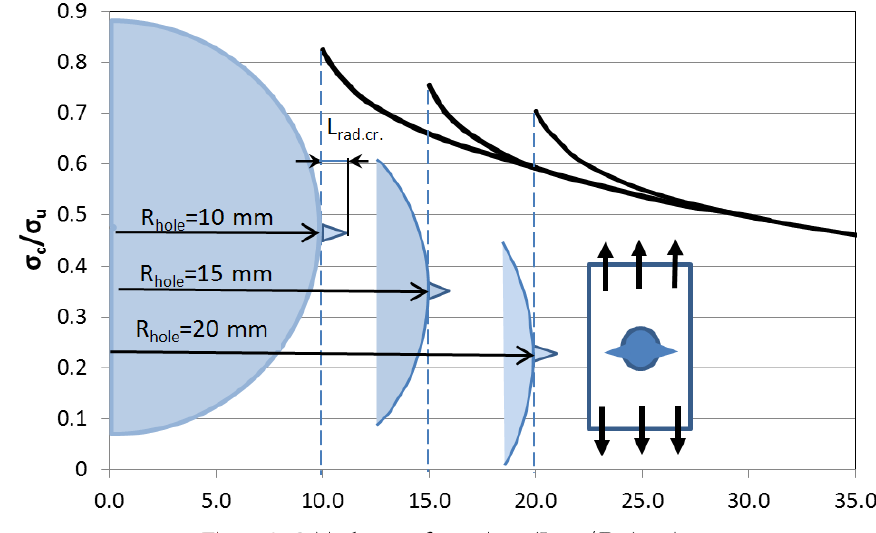
Figure 9: Critical stress for various ( L rad.cr. /D hole )-ratio